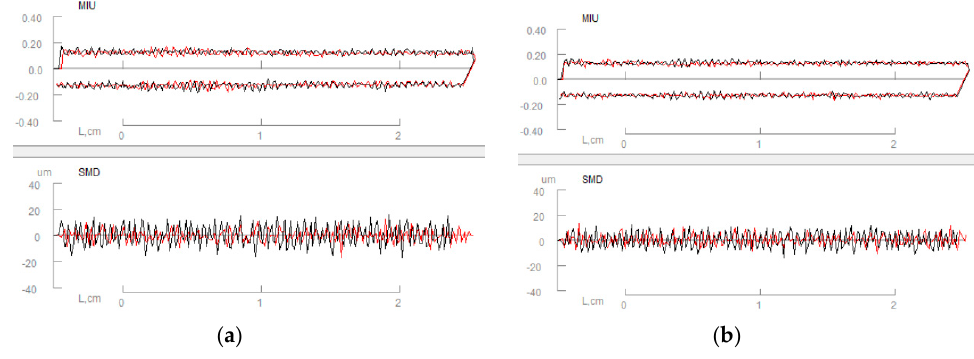
Figure 14. Principle of surface property measurement.